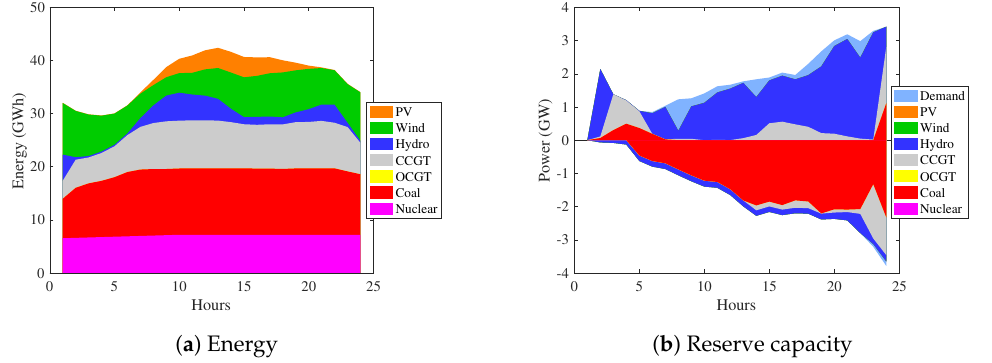
Figure 4. Day-ahead energy and reserve capacity